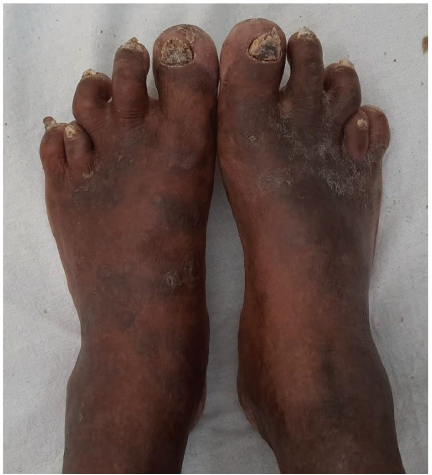
Figure 3: Short fourth metatarsals. Table 1: Summary of the investigation